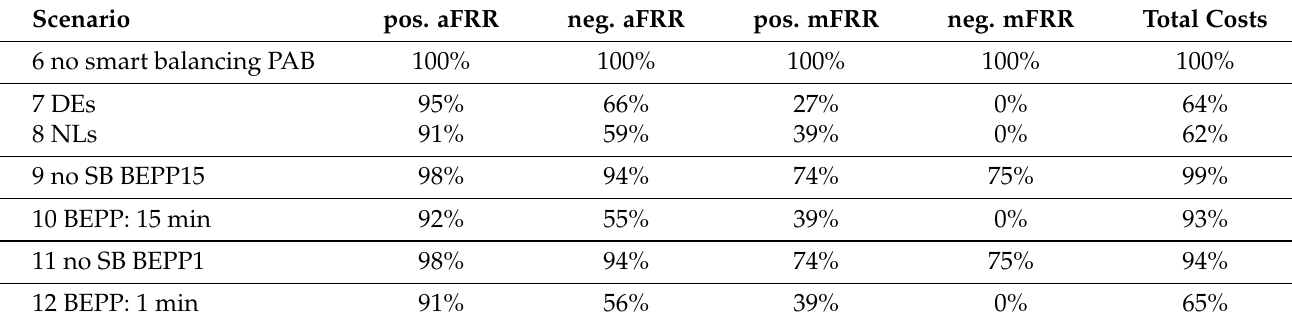
Table 10. Smart balancing simulation-activated FRR energy and total costs of scenarios with synthetic ACE.